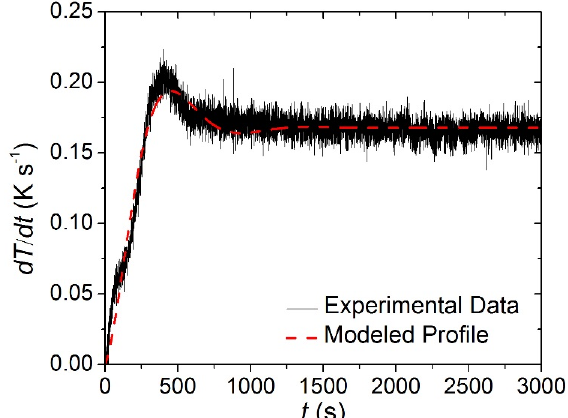
Figure 9. Experimentally observed and modeled heating rate histories typical of